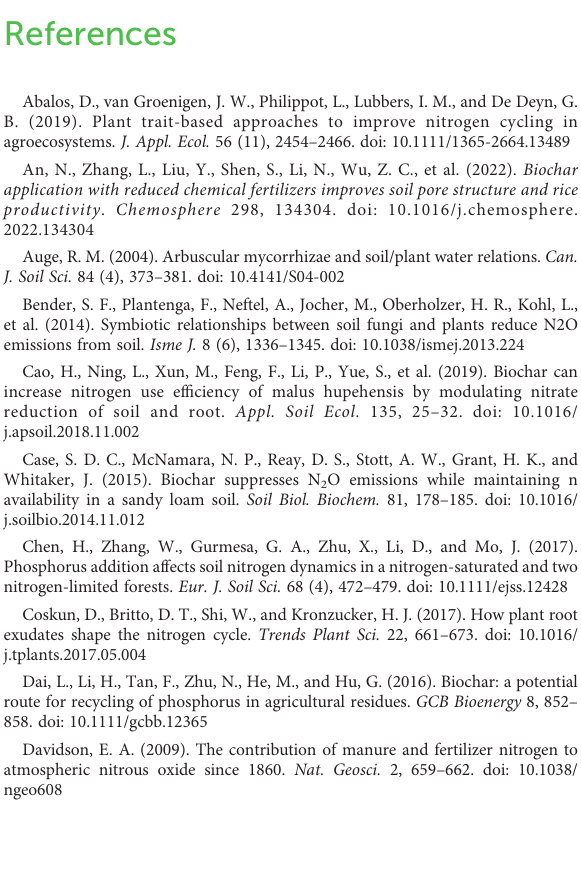
SUPPLEMENTARY FIGURE 2 (A) Heat map of Pearson ’ s correlation coef fi cients among N 2 O emission, gene copies, plant traits and soil properties under P300treatment (upper- right part) and P40 treatment (lower-left part) under greenhouse experiment. Each value is the mean of fi ve replicates( ± SE) (B) Heat map of Pearson ’ s correlation coef fi cients with original data among yield, N 2 O emission, gene copies in one-year fi eld experiment. Each value is the mean of four replicates ( ± SE). Note: shoot growth as a principal component includes shoot biomass, shoot phosphorus concentration and content, and shoot nitrogen concentration and content. Root growth as a principal component includes root biomass, total root length and root/shoot ratio. Root morphology as a principal component includes root diameter,speci fi croot lengthandroottissue density.Mn,matureleaf Mn concentrations; STN, soil total nitrogen content; SOC, soil organic carbon; MC%, mycorrhizal colonization. ** P <0.01 and * P